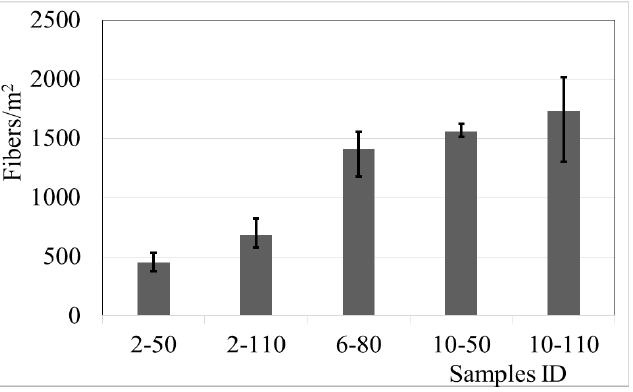
Figure 19. Number of fibres per square meter of concrete with recycled PET